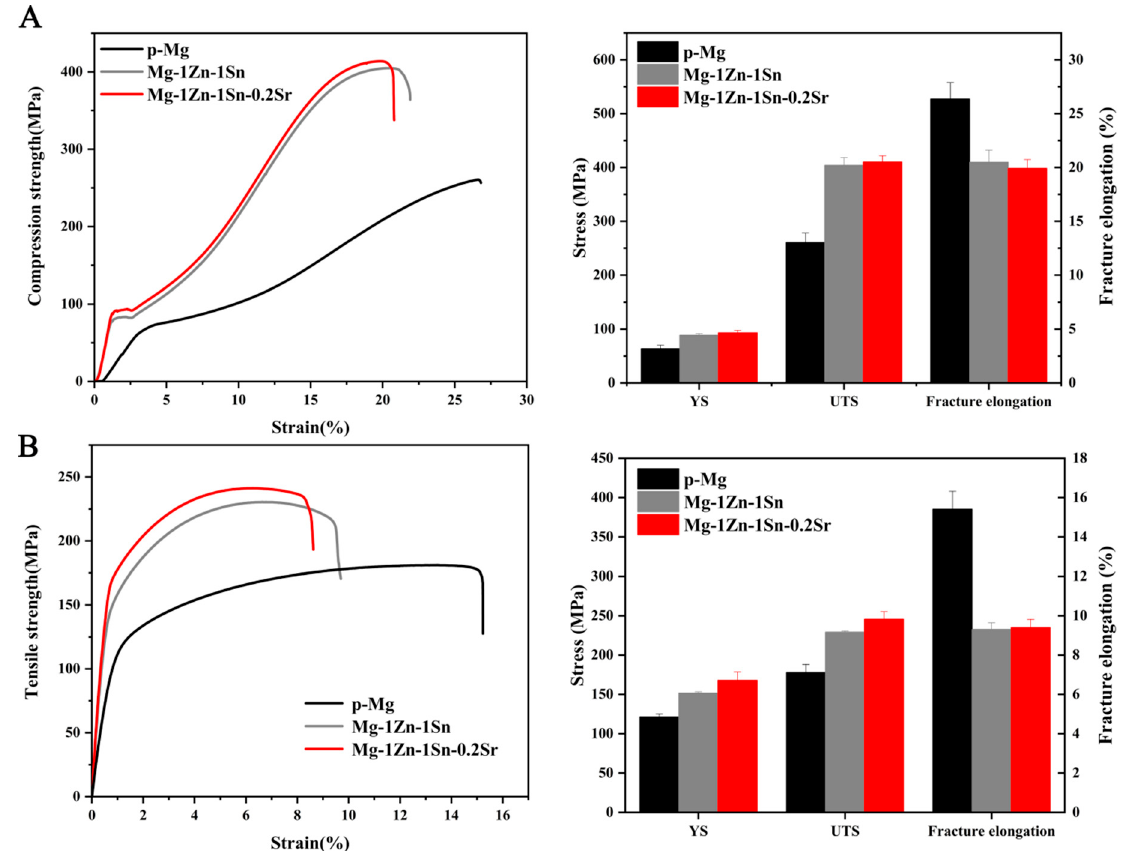
Figure 3. Mechanical properties of the p-Mg, Mg-1Zn-1Sn and Mg-1Zn-1Sn-0.2Sr alloys: ( A ) Compression stress–strain curves and graphs; ( B ) tensile stress–strain curves and graphs.